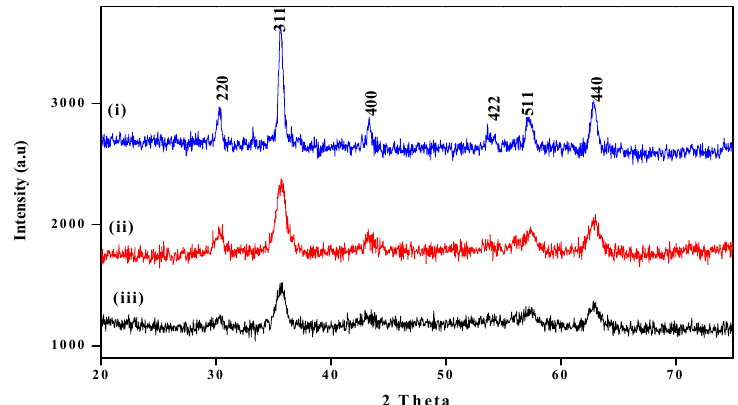
Figure 3. Diffractogram of: ( i ) MNP; ( ii ) MNP@PTh; ( iii ) MNP@P3TArH.